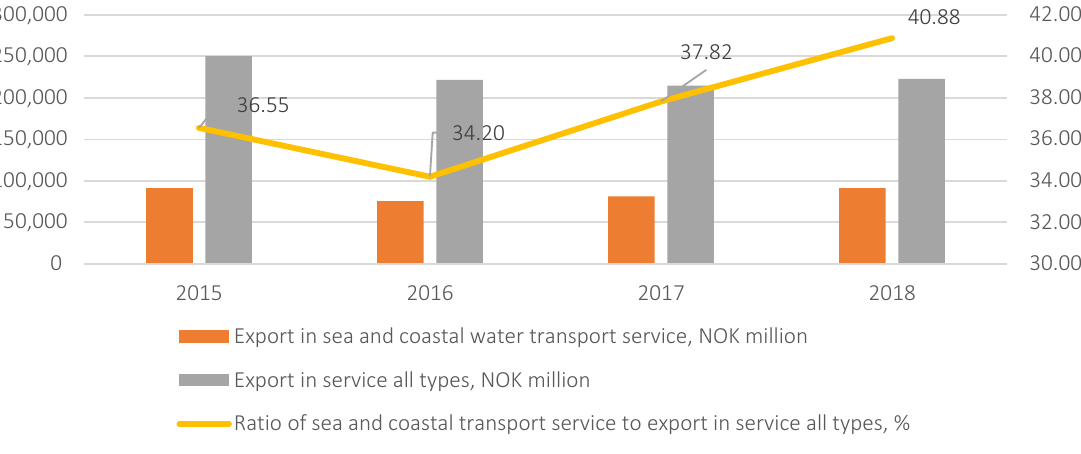
Figure 3. The dynamics of export in sea and coastal water transport services and share